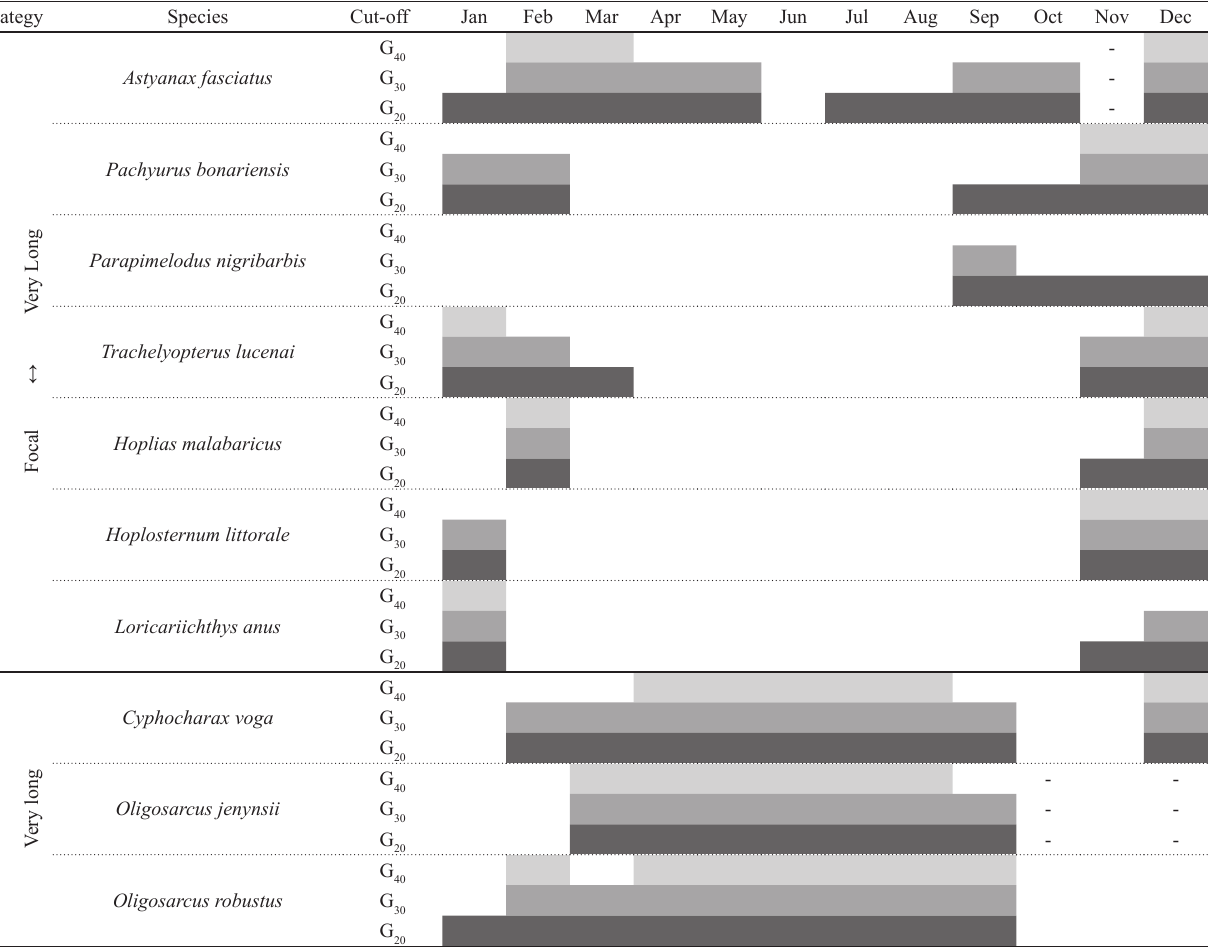
Tab. 2. Months with fish core reproduction based on GSI values, when at least one sample showed a median GSI equal or ), 30% (G ) or 40% (G ) of the maximum GSI value recorded for each species. Data for dominant fish greater than 20% (G 20 30 40 species in the Patos Lagoon basin (Guaíba Lake and Casamento Lake, Rio Grande do Sul,